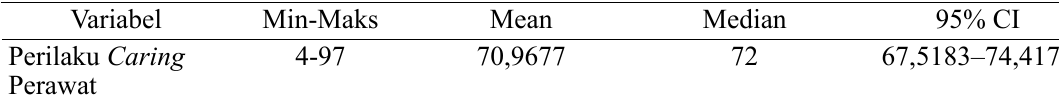
Tabel 2 . Diskripsi statistik perilaku caring